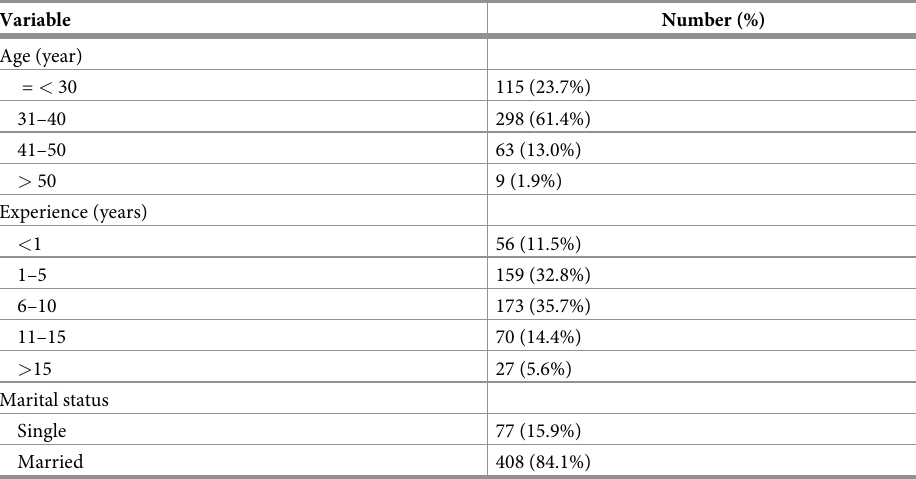
Table 1. Demographic characteristics of participants (n =